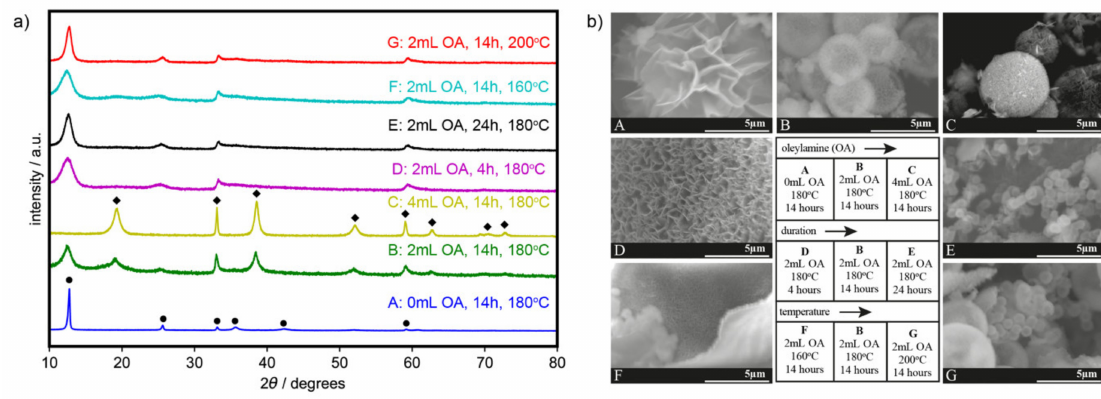
Figure 1. ( a ) X-ray di ff raction patterns ( α : • ; β : (cid:7) ; phases of Ni(OH) 2 ) and ( b ) scanning electron microscopy (SEM) images of the synthesized